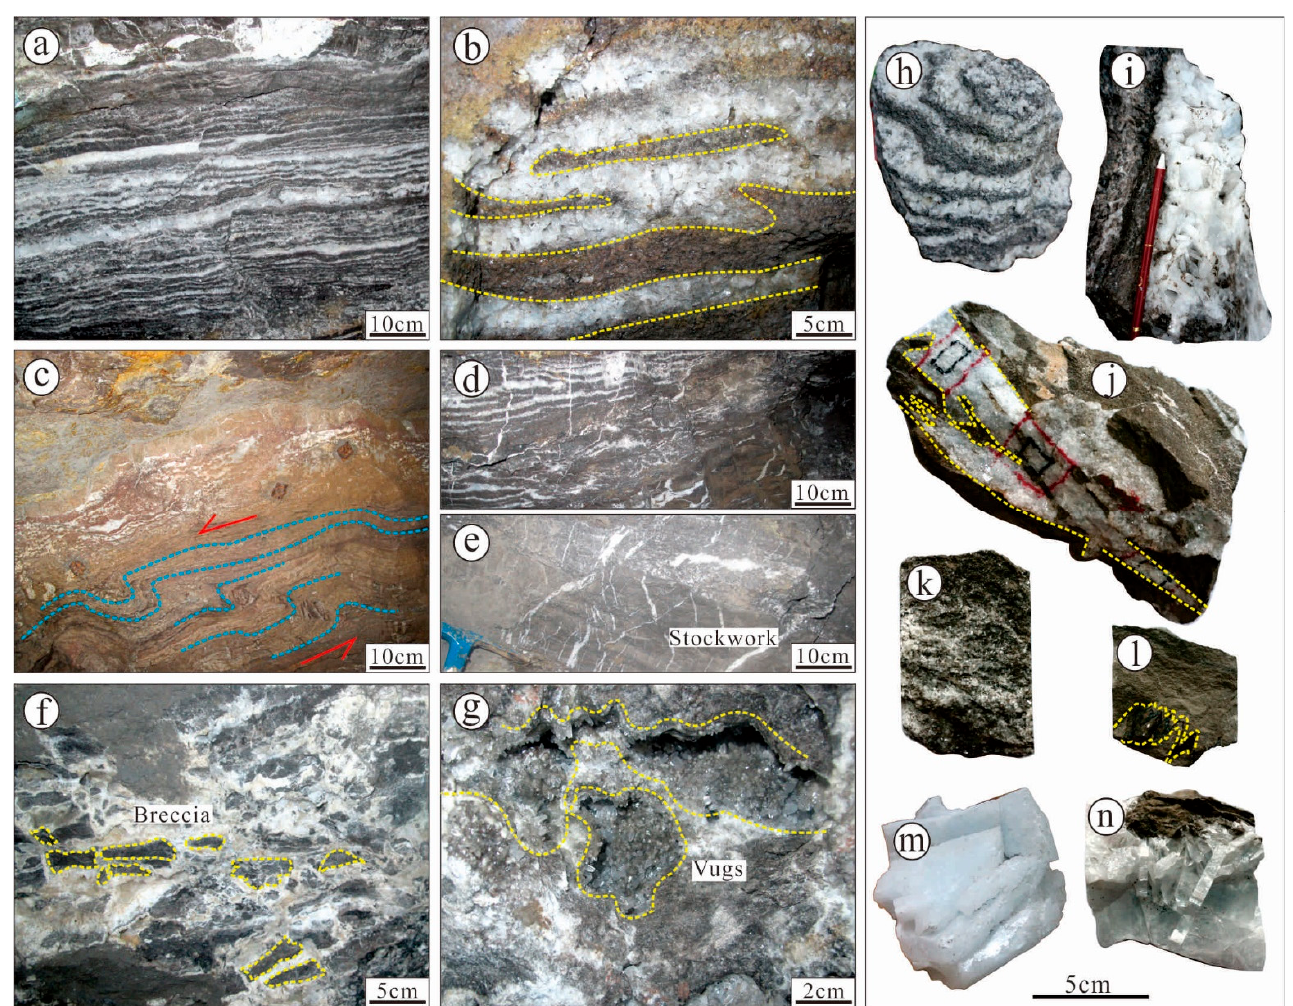
Figure 5. Photographs showing the characteristics of the ore bodies in the underground mine taken at a depth of 305 m and hand specimens collected from underground and drilling. ( a ) Banded celestine in the Jialingjiang Formation. ( b ) Partially enlarged photograph of banded ore, showing that the ore is composed of a dark microcrystalline carbonate band and a white tabular crystalline celestine band. ( c ) Flexure structure in country rock, with red arrows indicating the direction of strata movement. The ore body is not significantly deformed, indicating that it was formed after the tectonic movement. ( d ) Photograph of vein ore and banded ore, showing that they were formed during the same period of hydrothermal activity. ( e ) Reticulate ore. ( f ) Breccia ore; breccia is carbonate, and cement is celestine. ( g ) Photograph of celestine geode, showing celestincrystals as light blue columnar. ( h ) Banded ore. ( i ) White and light-blue celestine clusters. ( j ) Vein ore. ( k ) Disseminated ore. ( l ) Organic vein in dolomite. ( m ) Massive ore. ( n ) Plate-column celestine aggregate.